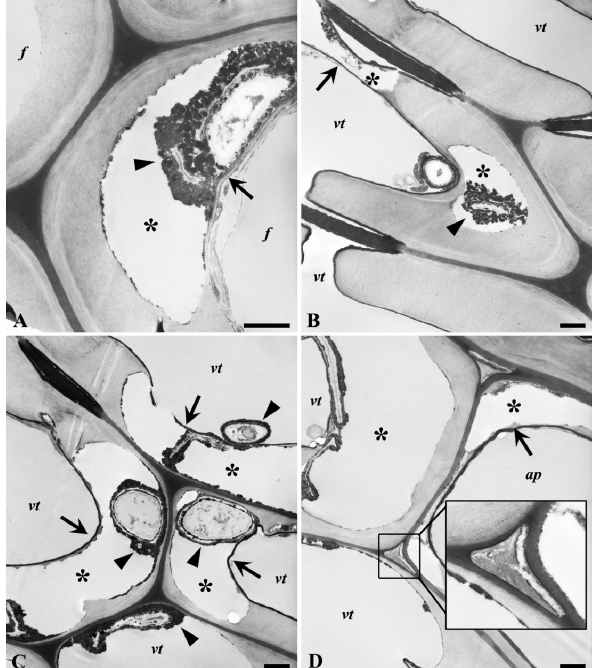
Figure 10. TEM observations of oak wood decayed by P. ostreatus . Formation of cavities (asterisks) in the secondary cell wall of the (libriform) fiber ( f , A ), (vasicentric) tracheid ( vt , B – D ), and axial parenchyma cell ( ap , C ) with remnants of the innermost S 3 layer (arrows in A – D ). Note accumulation of electron-dense materials around fungal hyphae in cavities (arrowheads in A – C ). Inset in D indicates fungal attack through intercellular spaces between tracheids associated with axial parenchyma cells. Scale bars: 1 µm. In contrast to P. ostreatus, degradation of fibers and tracheids by T. versicolor occurred by the erosion of the secondary wall from the lumen outwards (Figure 11A,B). At advanced stages of decay, degradation of ML regions was detected (Figure 11A). At the early stages of decay, degradation of secondary cell walls through intercellular spaces was frequently observed in fibers and tracheids (arrows in Figure 11C). Decay initiated from intercellular spaces and electron-lucent regions of middle lamella cell corner (MLcc) regions progressed into the secondary cell wall and ML regions (Figure 11D). Interestingly, pit membranes between tracheids appeared resistant to degradation (arrowheads in Figure 11B,D), which may reflect their infiltration with extractives, judging by their highly electron-dense appearance.